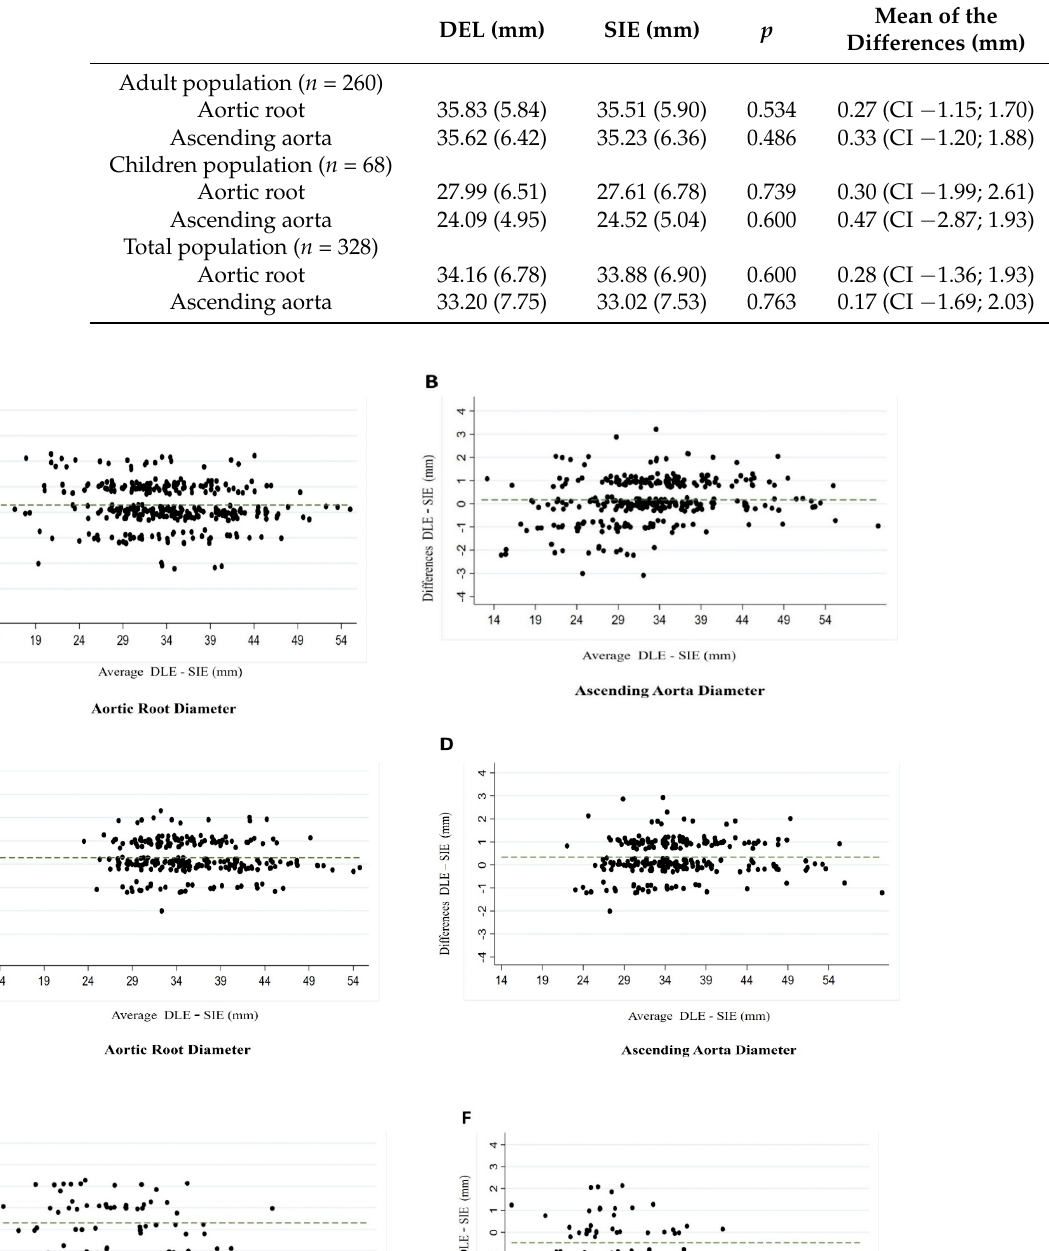
Table 2. Median aortic diameters and mean of the differences in adult, children, and total population.